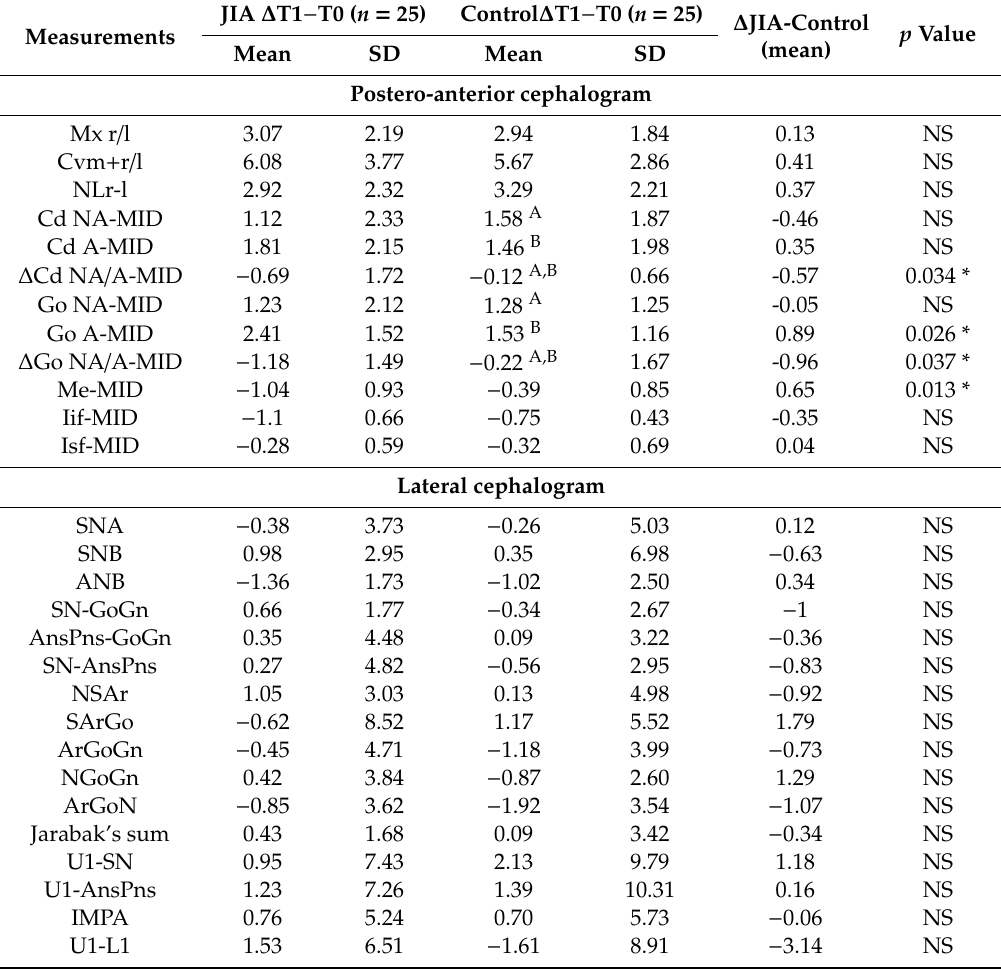
Table 4. Jia vs Control group. Mean, standard deviation (SD) of measurements between T1 − T0 and comparisons of values within JIA group and control group with independent t